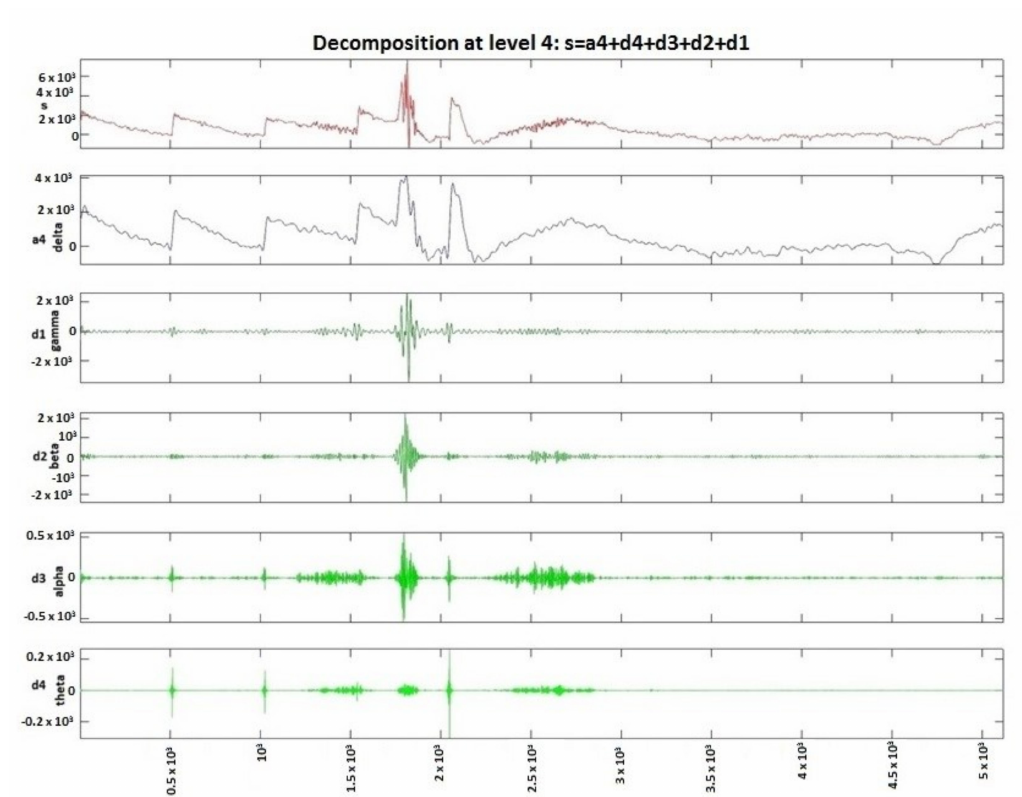
Figure 3. Patient before and after the seizure, signal decomposition on four levels using DWT.